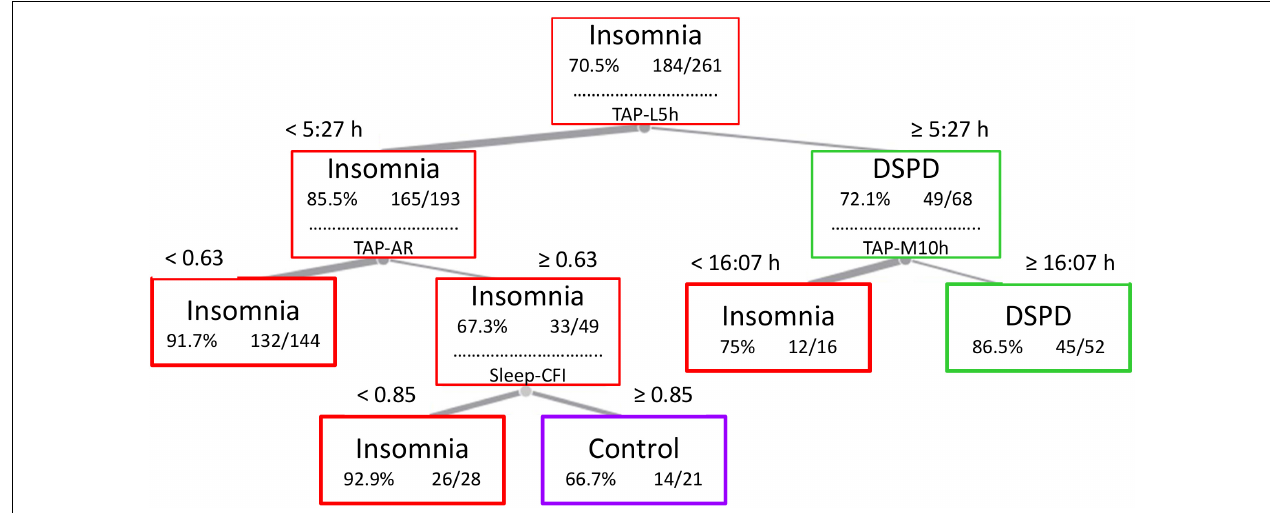
FIGURE 2 | Decision tree and cut values used by the model to generate five final classes: DSPD (with both delayed mid-sleep and central time of maximal activation), OI (delayed mid-sleep time, but not central time of maximal activation), MI (normal sleep phase and low relative amplitude and CFI), mild insomnia (which only differed from the controls in terms of their sleep rhythm robustness), and healthy controls. TAP-L5h, midpoint timing of the five consecutive hours of lowest TAP values; TAP-M10h, midpoint timing of the 10 consecutive hours of maximal TAP values; TAP-AR, relative amplitude of TAP rhythm; Sleep CFI, circadian function index of sleep